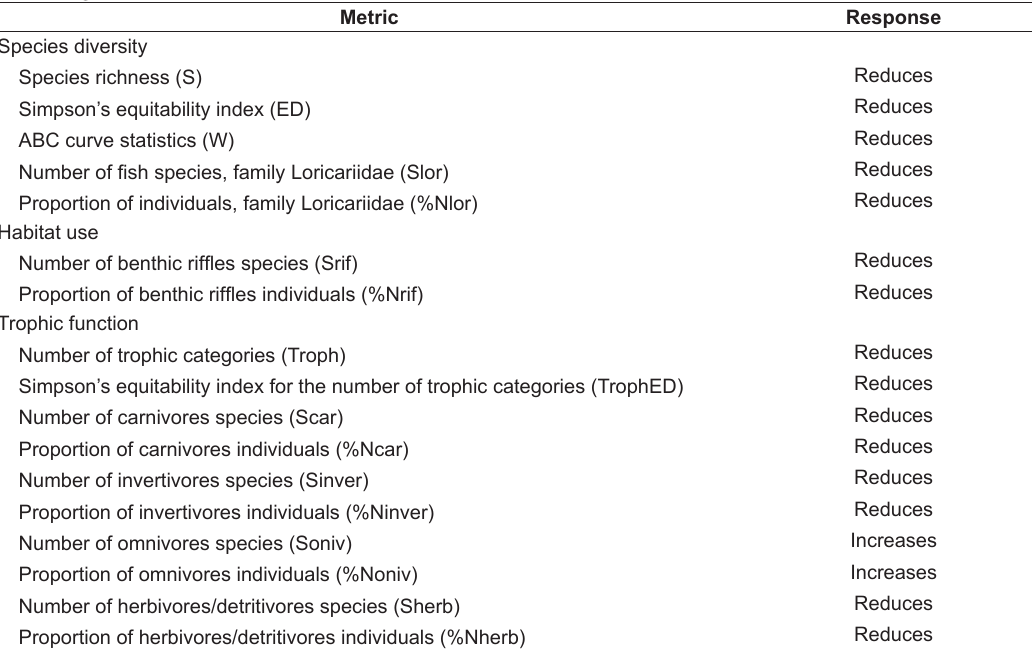
Table 3. Candidate metrics for the Index of Biotic Integrity and the expected response to an increase in environ- mental degradation.